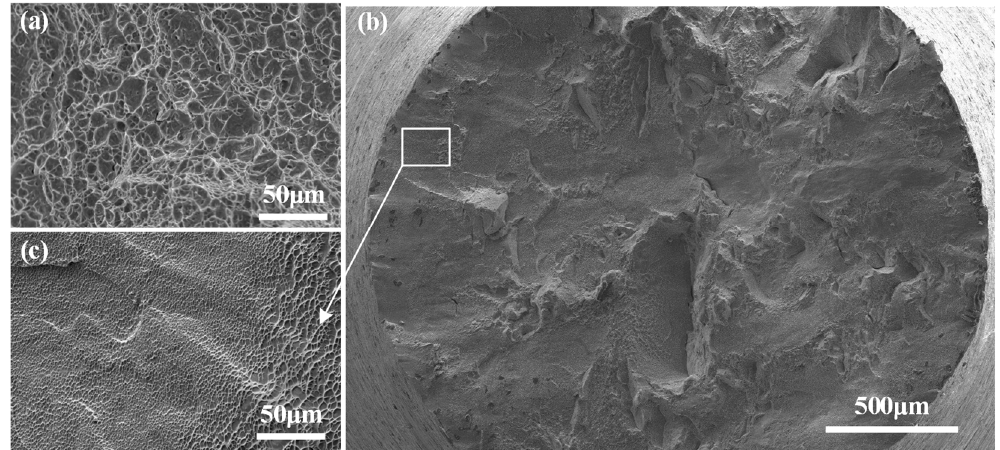
Figure 5. Fracture morphologies after SSRT of the AM1 alloys: ( a ) the image for dimples of the specimen tested in air; ( b ) macro morphology of the specimen tested in 3.5% NaCl aqueous solution; ( c ) the image for dimples of the specimen tested in 3.5% NaCl aqueous solution.